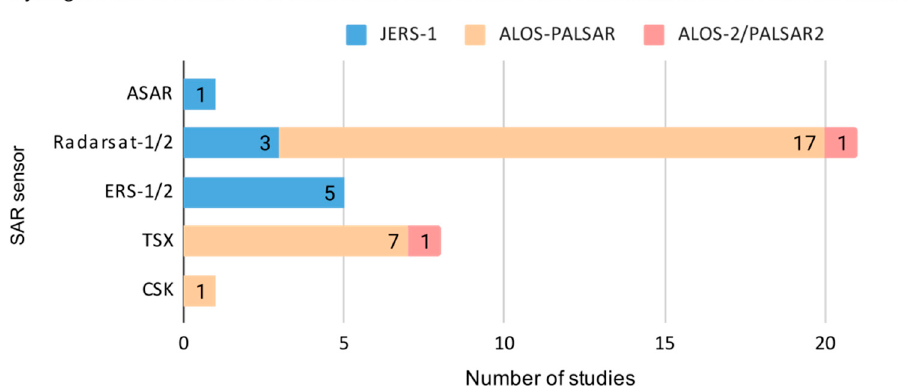
Figure 9. Number of reviewed studies with synergetic use of L-band SAR and shorter wavelength (C- band and X-band) SAR systems. (C-band and X-band) SAR